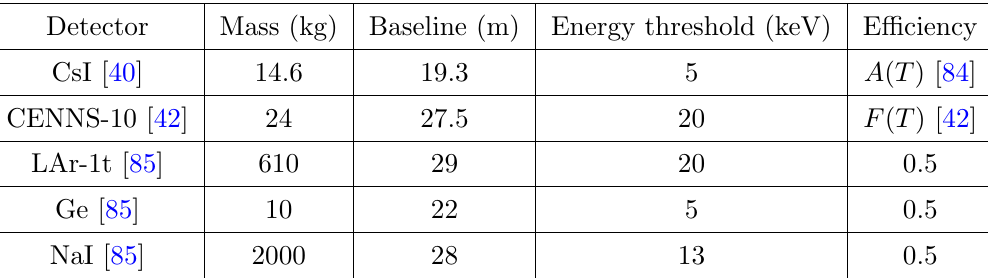
Table 5 . Speci(cid:12)cations of the current COHERENT-CsI [40] and CENNS-10 [42] detectors, along with the future setups using other type of detectors [85]. For CENNS-10, the e(cid:14)ciency function F ( T ) is taken from (cid:12)gure 3 of ref. [42] for the analysis B. Since there is no information about the e(cid:14)ciencies of the future detectors (viz, LAr-1t, Ge, and NaI), we have assumed a conservative (cid:13)at e(cid:14)ciency of